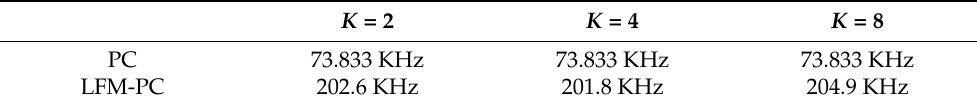
Table 3. Doppler